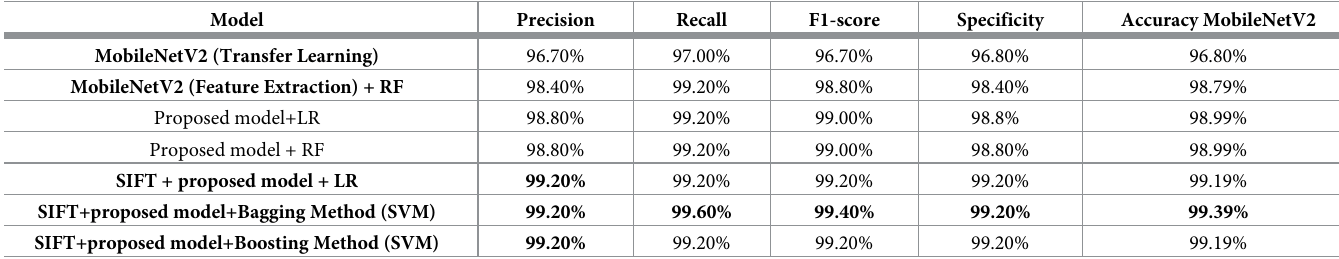
Table 2. Testing scores of the proposed methods for COVID-19